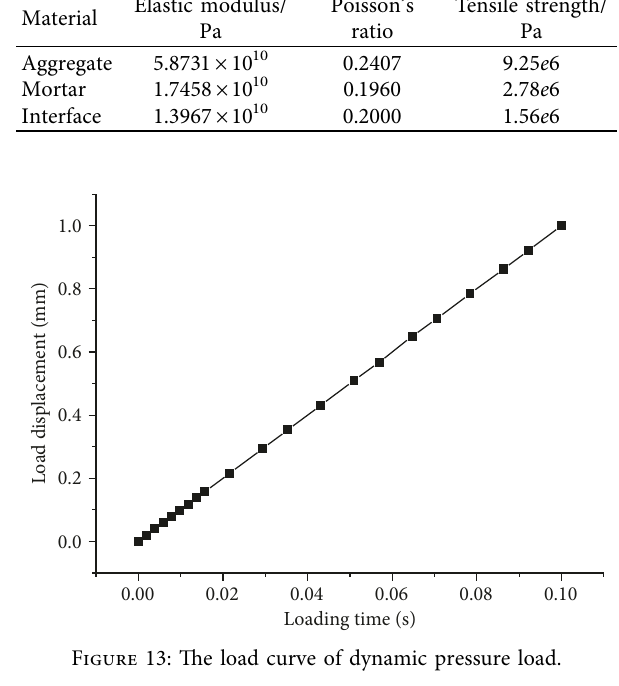
Figure 13: The load curve of dynamic pressure load.